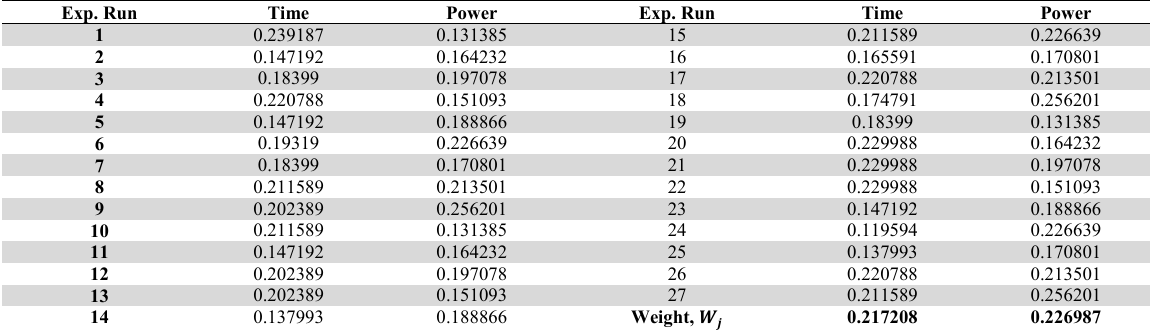
Normalized decision matrix